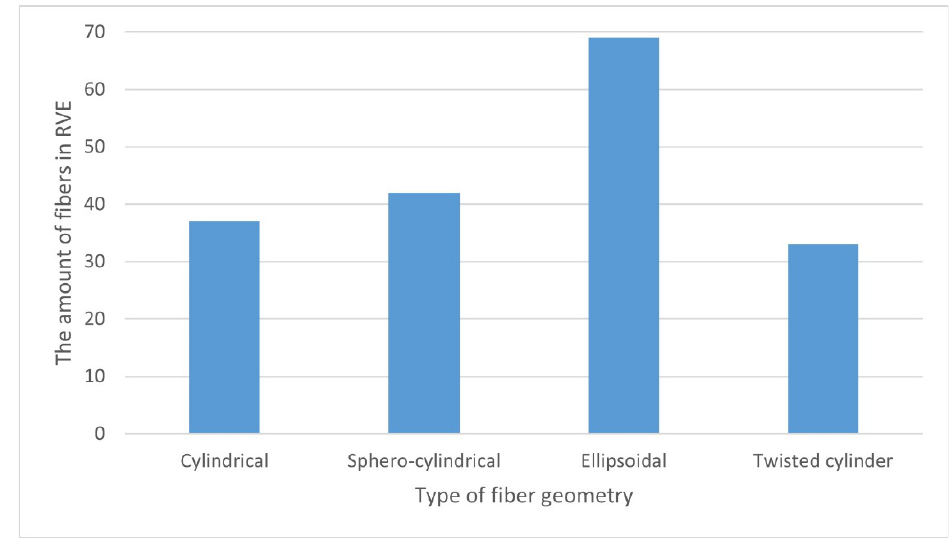
Figure 9. Dependence of the amount of fibers in the RVE on their geometry. Table 8. Calculated values of the orientation tensor after converting data from Autodesk Moldflow Insight to RVE in Digimat